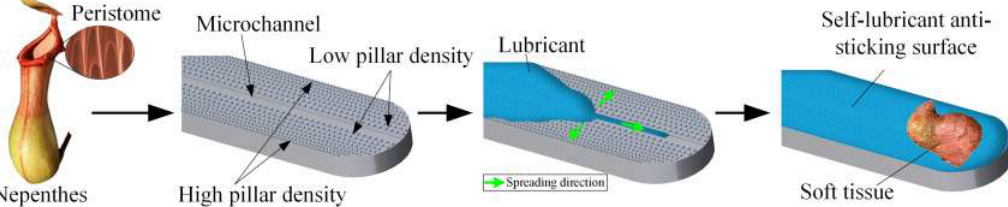
Figure 1. Nepenthes-inspired self-lubricating anti-sticking surface with wettability gradients.